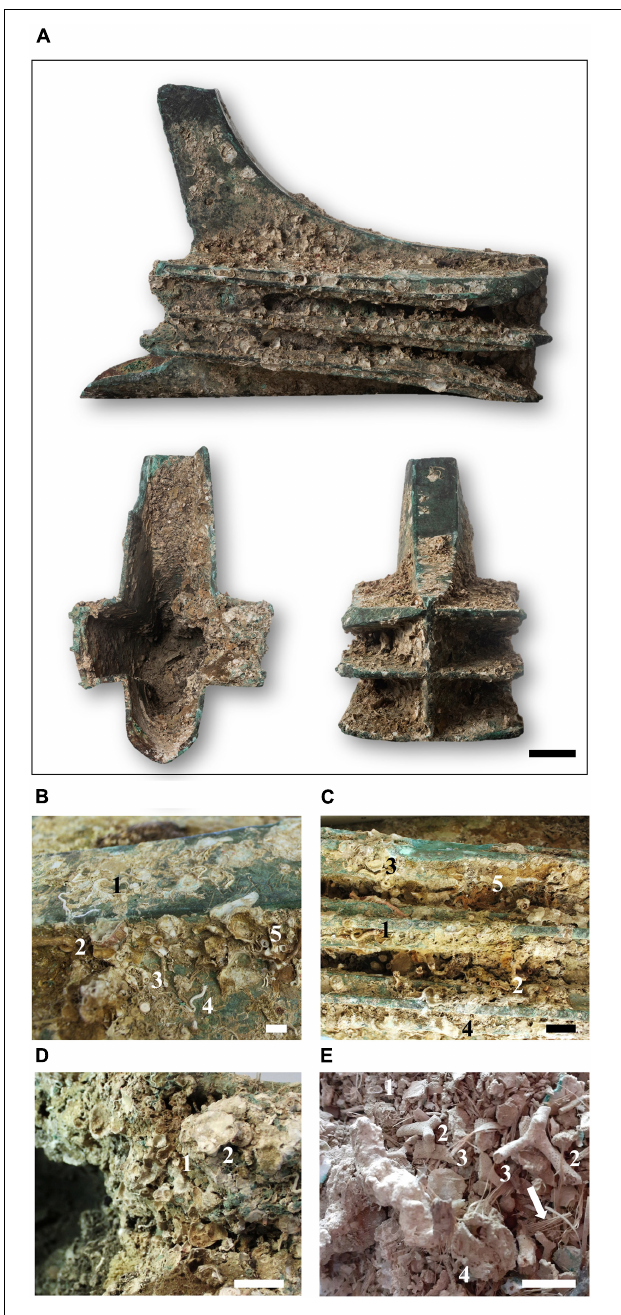
FIGURE 2 | The ram Egadi 13 (A) and details of the biological colonization. Numbers mark calcareous tubes of serpulids: 1, Spirobranchus triqueter ; 2, Serpula vermicularis ; 3, Vermiliopsis monodiscus ; 4, Metavermilia multicristata ; and an oyster valve, 5 (B) ; tubes of serpulids: 1, Serpula vermicularis ; 2, Spiraserpula massiliensis ; 3, Vermiliopsis monodiscus ; 4, an oyster valve; 5, erect colony of the bryozoan Cellaria fistulosa (C) ; examples of engineering of encrusting organisms: 1, a bryozoan laminar colony growing around a serpulid tube; 2, a large encrusting bryozoan bindering some tubes of serpulids (D) ; examples of calcareous remains inside the ram: 1, valve of Asperarca sp.; 2, colonies of the bryozoan Myriapora truncata , 3, Pentapora fascialis , 4, Hornera sp.; the arrow marks vegetable fibers of Posidonia (E) . Scale bars: (A) = 10 cm; (B,D,E) = 1 cm; (C) = 2